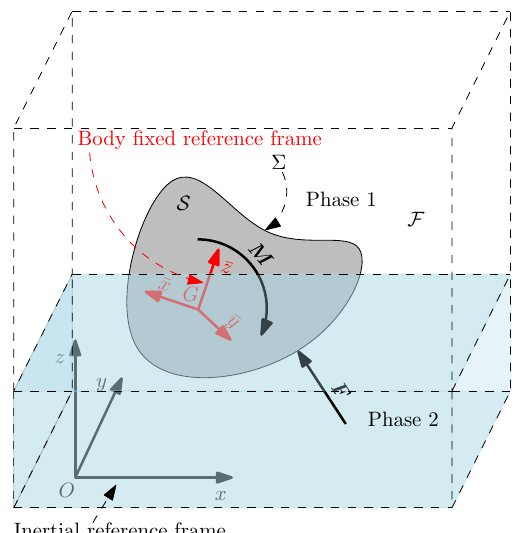
Figure 1. Schematic representation of the